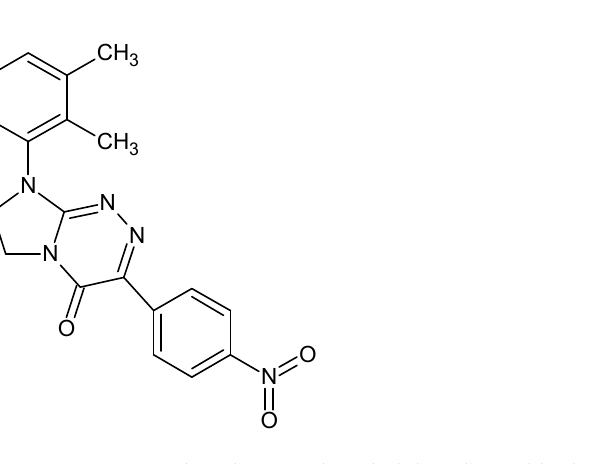
Figure 1. Figure 1. 3-(4-Nitrophenyl)-8-(2,3-dimethylphenyl)-7,8-dihydroimidazo[2,1- c ][1,2,4]triazin-4(6 H )-one 3 ‐ (4 ‐ Nitrophenyl) ‐ 8 ‐ (2,3 ‐ dimethylphenyl) ‐ 7,8 ‐ dihydroimidazo[2,1 ‐ c ][1,2,4]triazin ‐ 4(6 H ) ‐ one (NDIT)—an electroactive small molecule used in the present (NDIT)—an electroactive small molecule used in the present study.